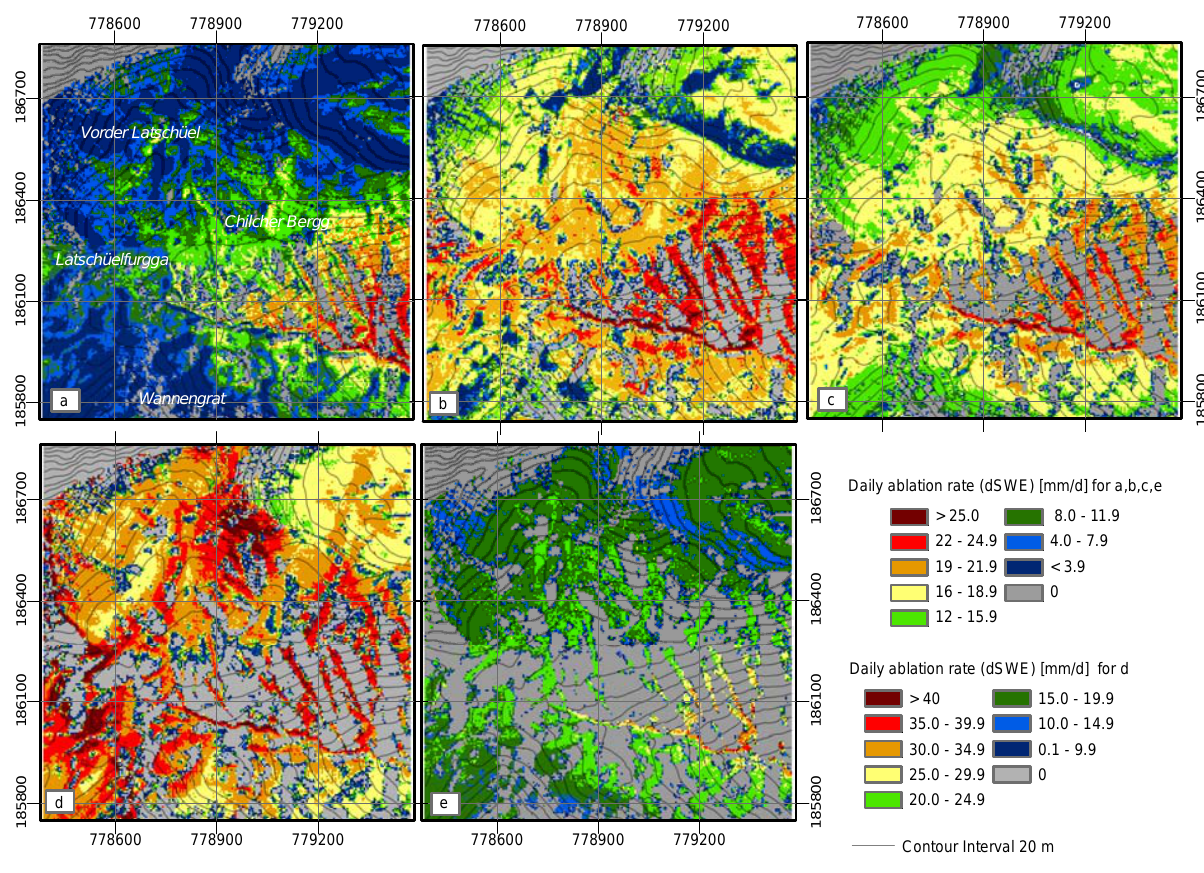
Fig. 4. Modeled daily ablation rates (dSWE) for ablation periods P2 (a) , P 3 (b) , P4 (c) , P5 (d) and P6 (e) . Note that legend is different for P5. The x- and y axes give swiss coordinates in meters. (base map: Pixelkarte PK25 swisstopo (dv033492)) wind-exposed areas provoking turbulent fluxes (Fig.